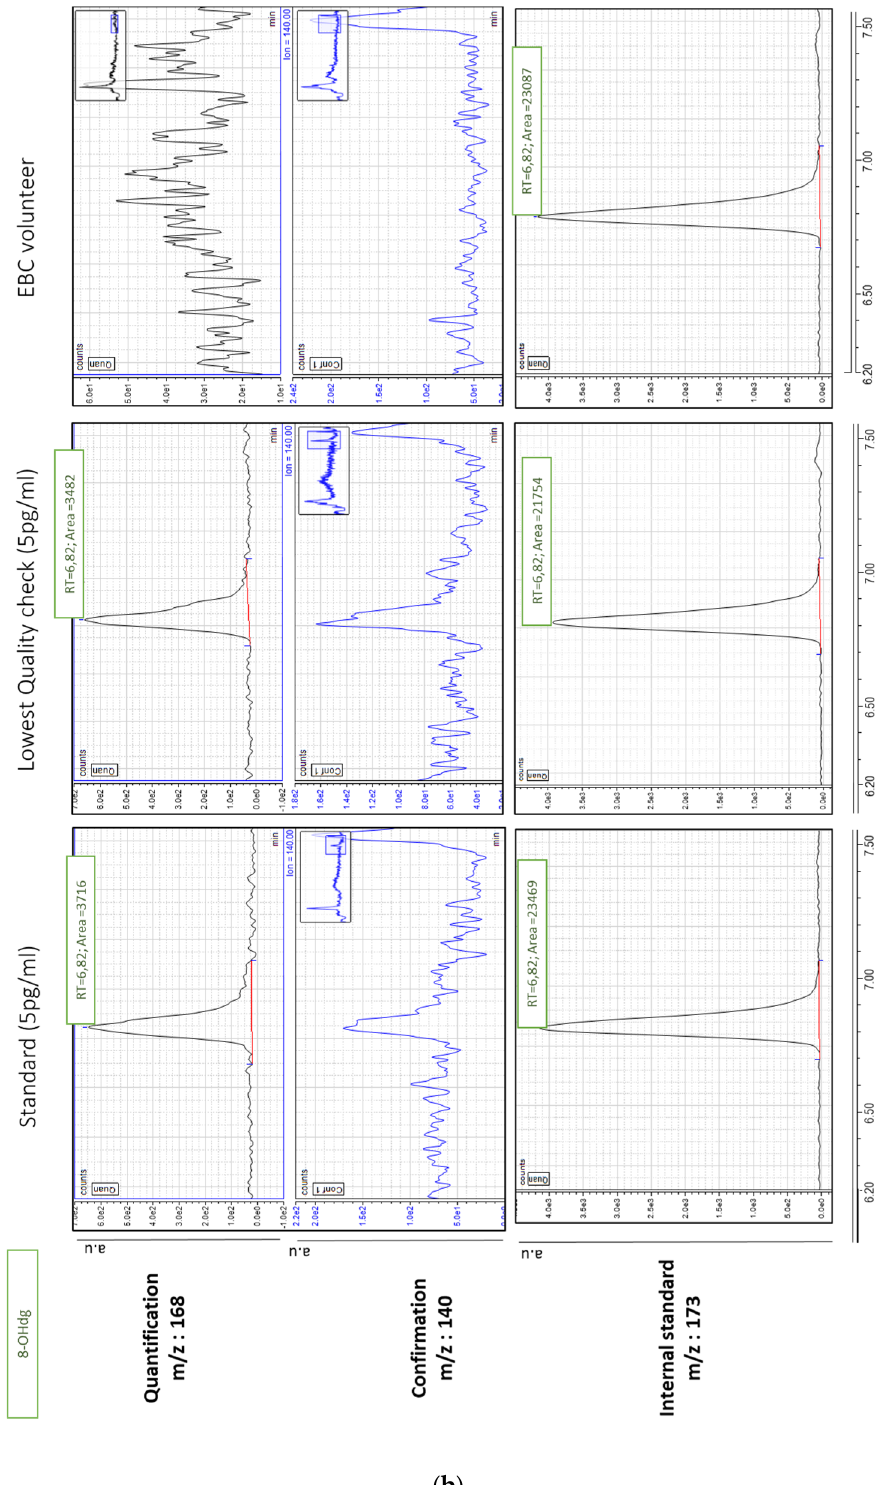
Figure 1. ( a , b ) Partial chromatogram of a standard injection at 5 pg/mL (left), of the lowest quality check (spiked EBC at 5 pg/mL, middle) and of a typical EBC sample (right), with retention times (RT) for 8-isoprostane and 8-OHdG, respectively. The units of the y -axis are in arbitrary units, counts per second. ( a , b ) are chromatograms obtained from the same healthy volunteer.